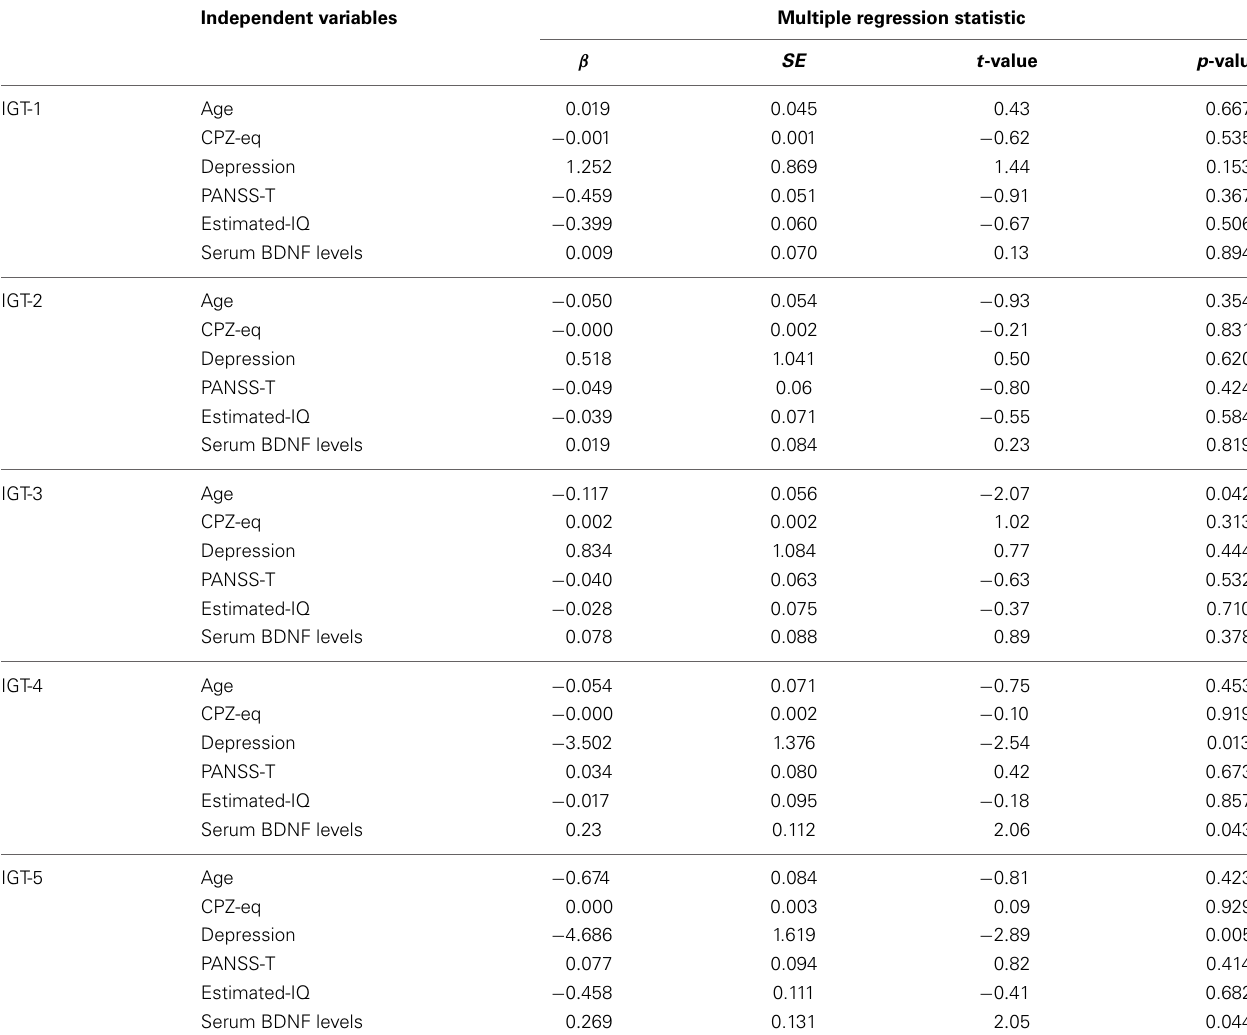
Table 4 | Multiple regression analysis results for the mean net scores on each block of the trials. Independent